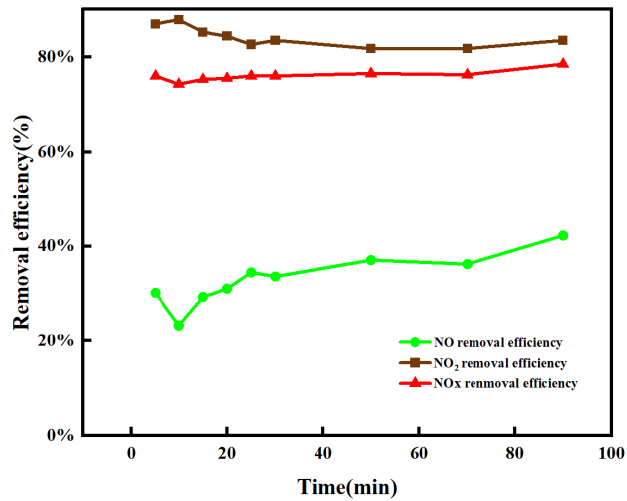
Figure 4. ( a ) The efficiency of catalysts with different Mn:Ce molar ratios for the catalytic ozonation of NO when the volume of O 3 :NO = 1:4; ( b ) The effect of increasing the ratio of O 3 on NO removal without catalyst; ( c ) Under the synergistic catalysis of Mn-Ce (4:1)/Al 2 O 3 /TiO 2 catalyst, increasing the ratio of O 3 on NO removal Impact.